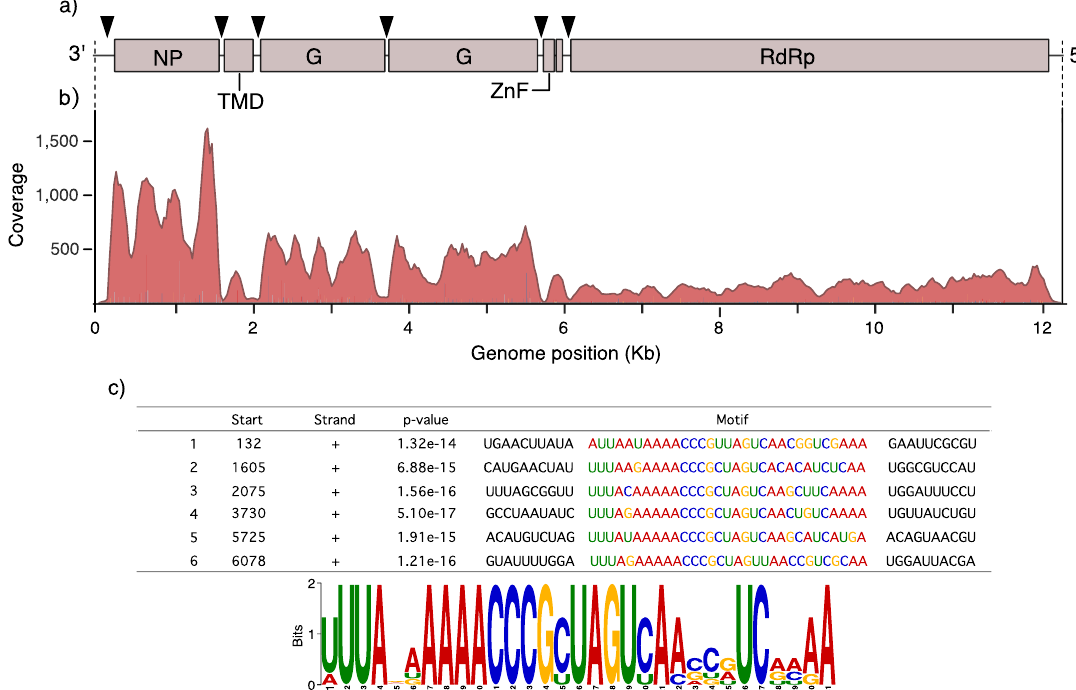
Figure 1. Aedes albopictus anphevirus (AealbAV) genome organization and conserved motif. ( a ) Genomic organization of AealbAV. Predicted ORFs are indicated with boxes. Positions of the 31-nt conserved motif are indicated by triangles. NP, nucleoprotein; TMD, Transmembrane domain; G, glycoproteins; ZnF, zinc-like finger; RdRP, RNA-dependent RNA polymerase. ( b ) Example of a mapping profile from 1 library (SRR458463) displaying the characteristic 3 (cid:48) –5 (cid:48) transcription gradient typical of replicating monenegaviruses. ( c ) Sequences and logo of the 31-nt conserved motif as estimated by